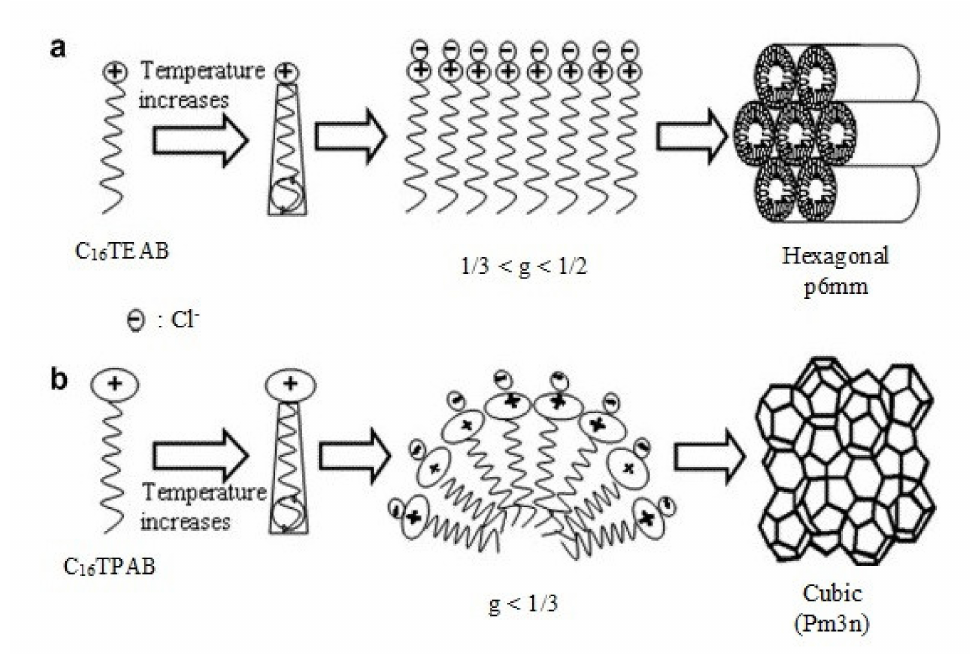
Figure 2. Schemes of changes in the ordering of surfactant micelles obtained with increasing temperature for ( a ) C 16 TEAB and ( b ) C 16 TPAB. Reprinted with permission from Reference [33] with minor